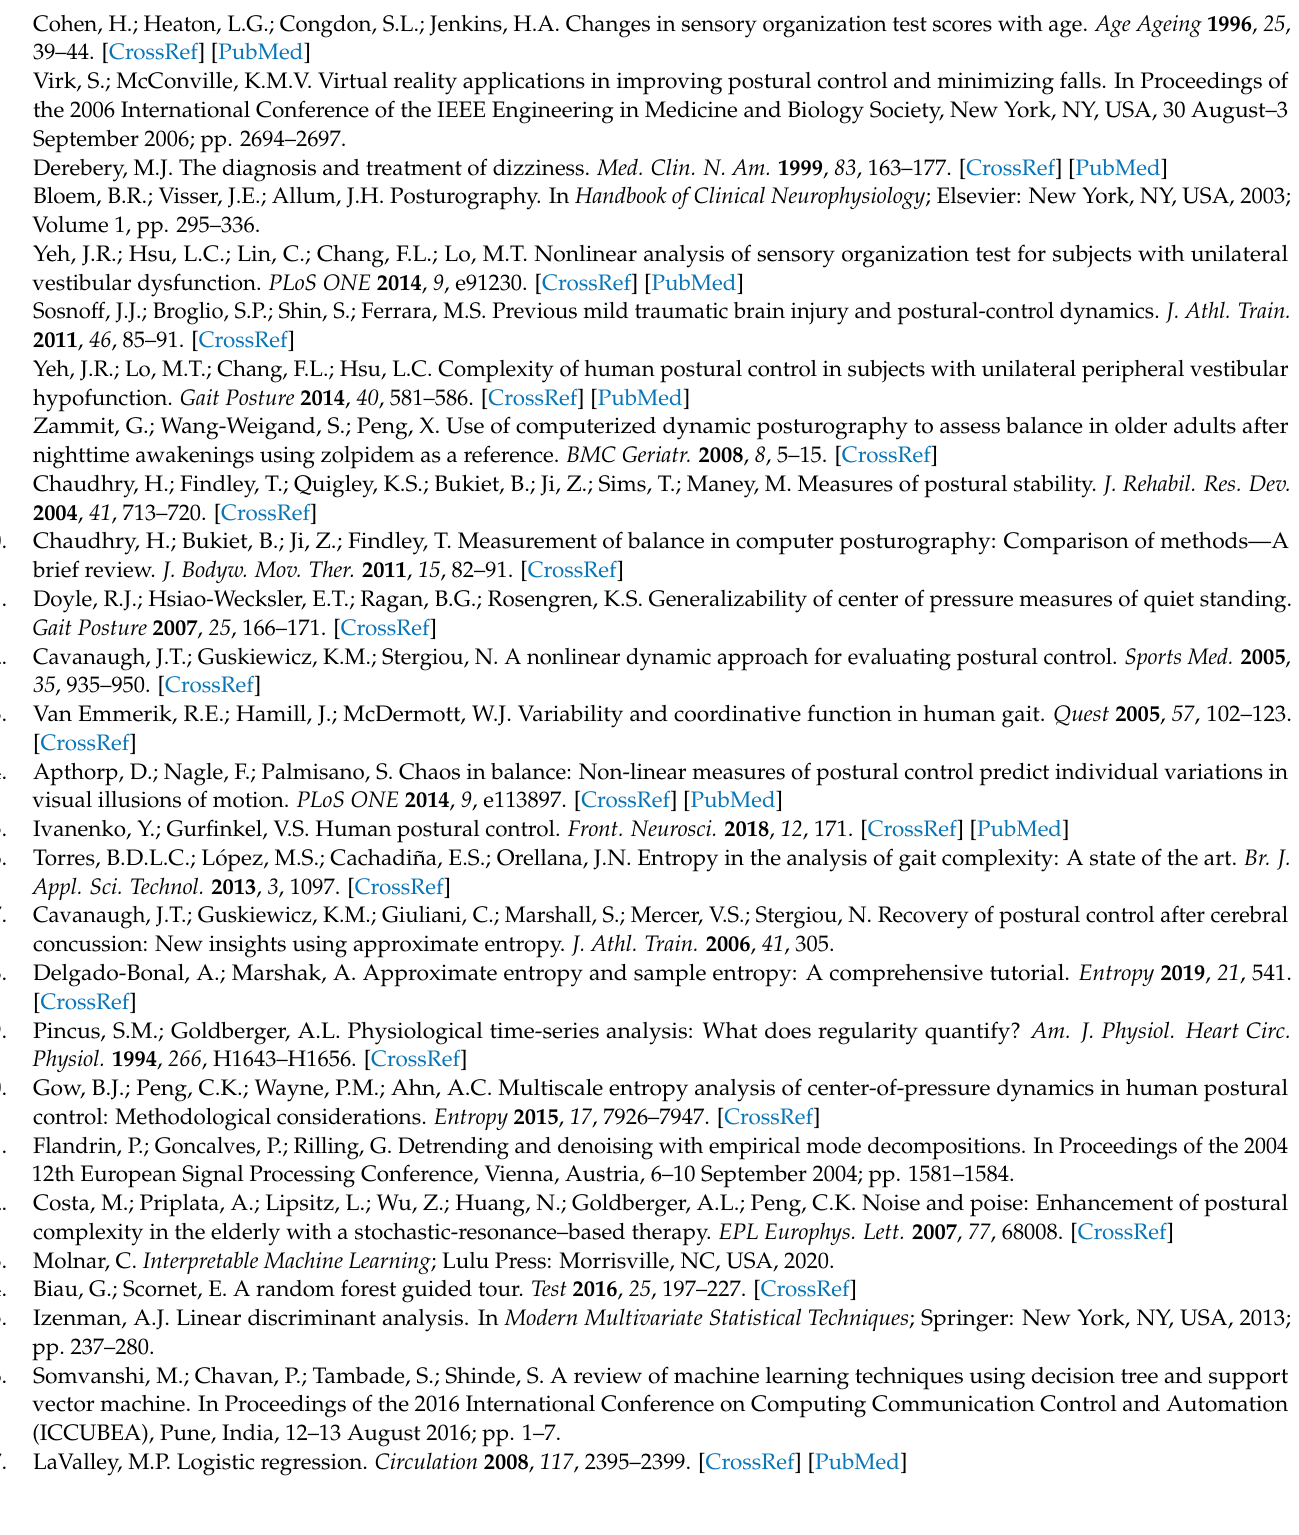
Table A2 provides information about comparing each diagnosis with the other(s) using the Two-Sample Kolmogorov–Smirnov Test. Those diagnoses with a significant difference are represented with an initial letter diagnosis superscript to indicate that they are different. According to Table A2, Normal Balance (N) and Traumatic Brain Injury (T) patients 47 years old or older show a consistent difference across all the SOT